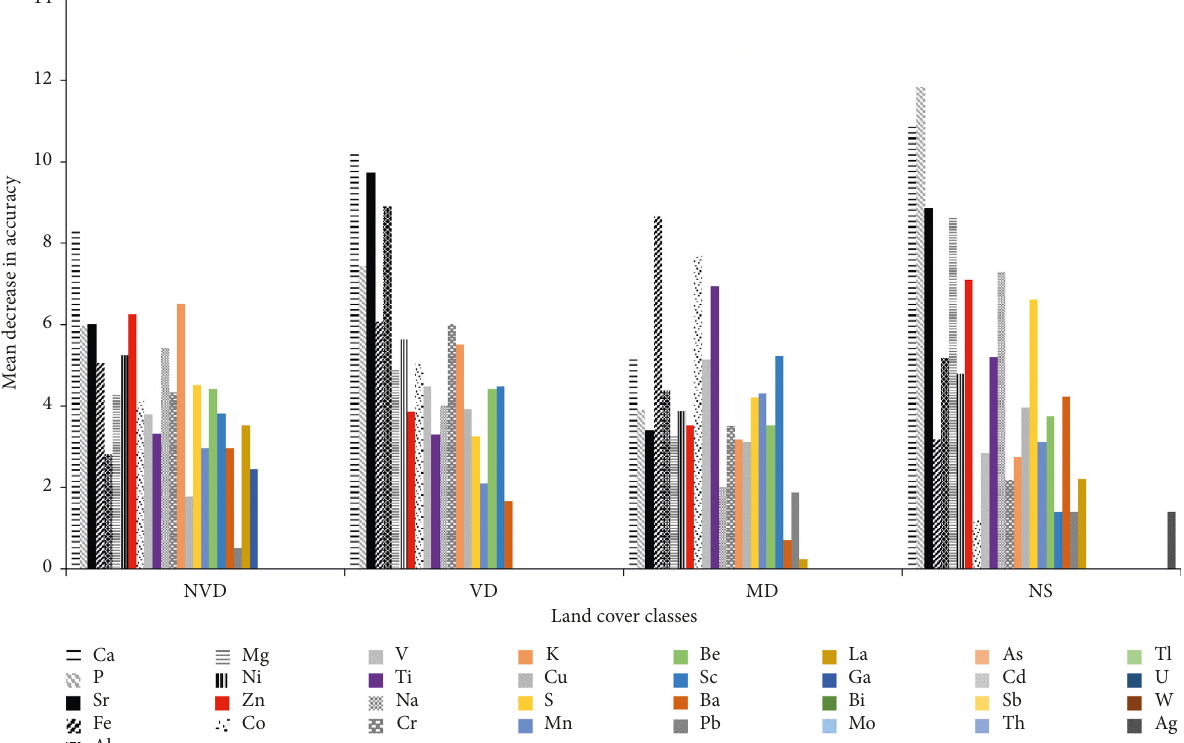
Figure 5: The importance of different elements in discriminating among the four soil classes: NVD, VD, MD, and NS. Elements with high MDA are the most important in the prediction